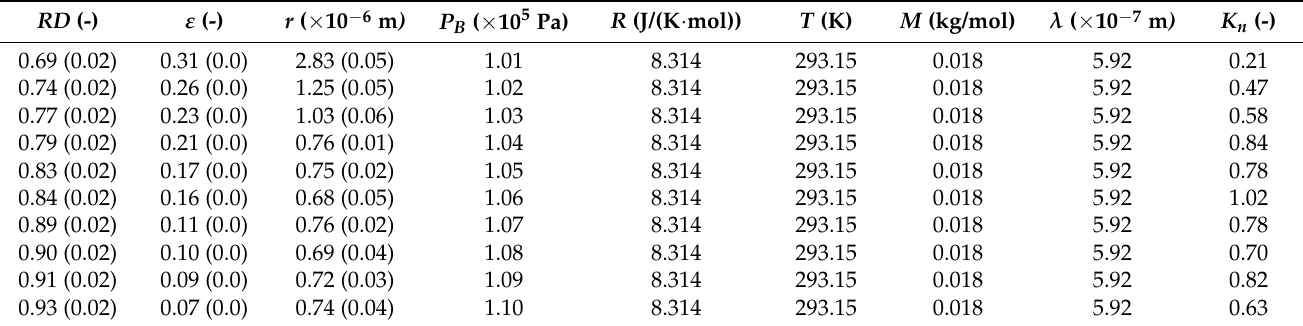
Figure 13. Variation of the normalized moisture transfer coefficient with the compressed MCC PH101 powder normalized tablet porosity.